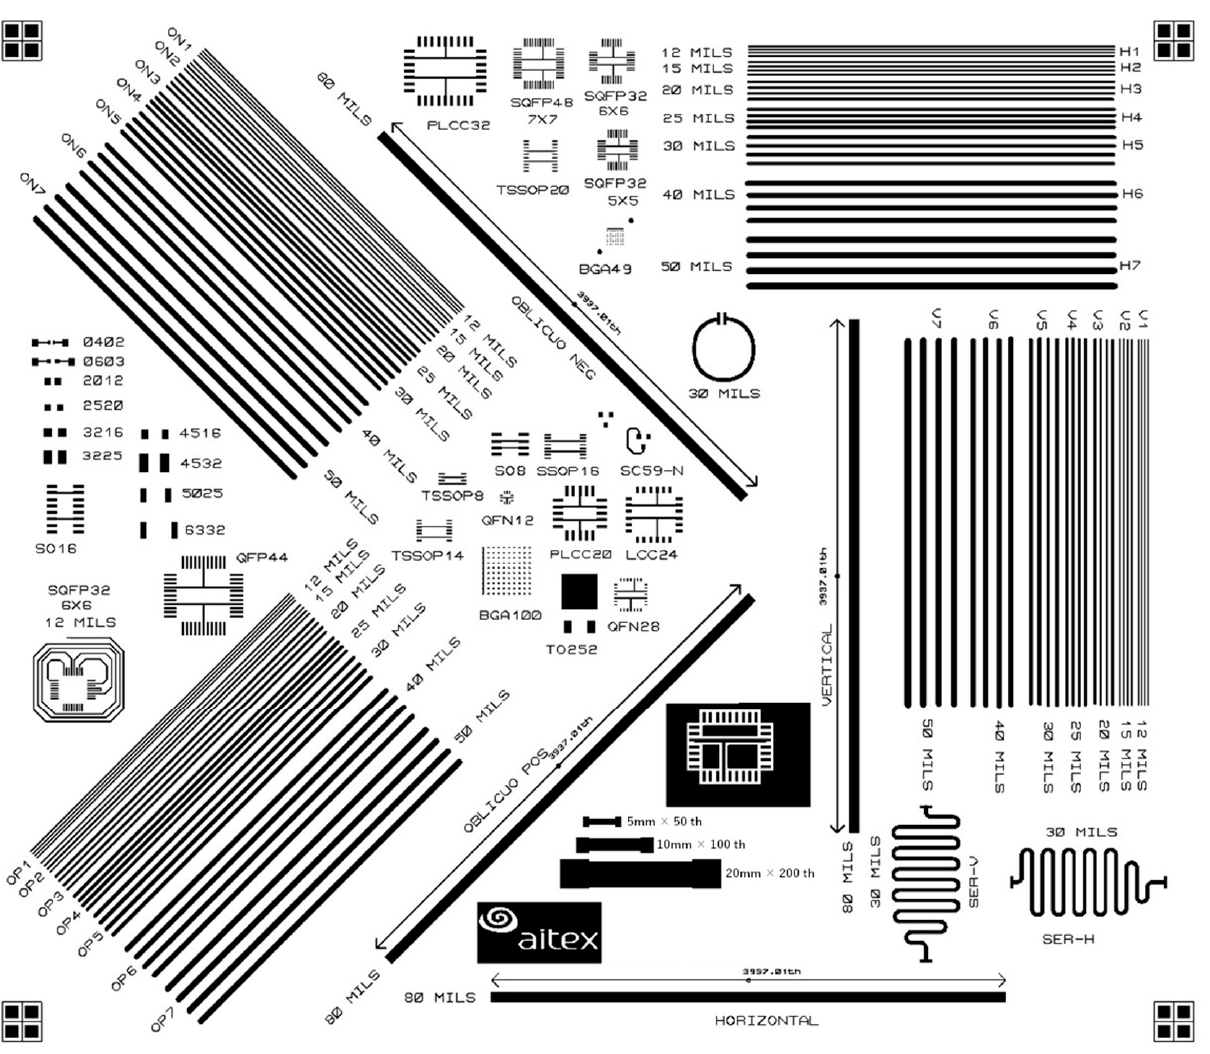
Figure 1. Patterns with tracks of different sizes and orientations, land patterns of different sizes, and pitches used to determine the minimum design parameters.